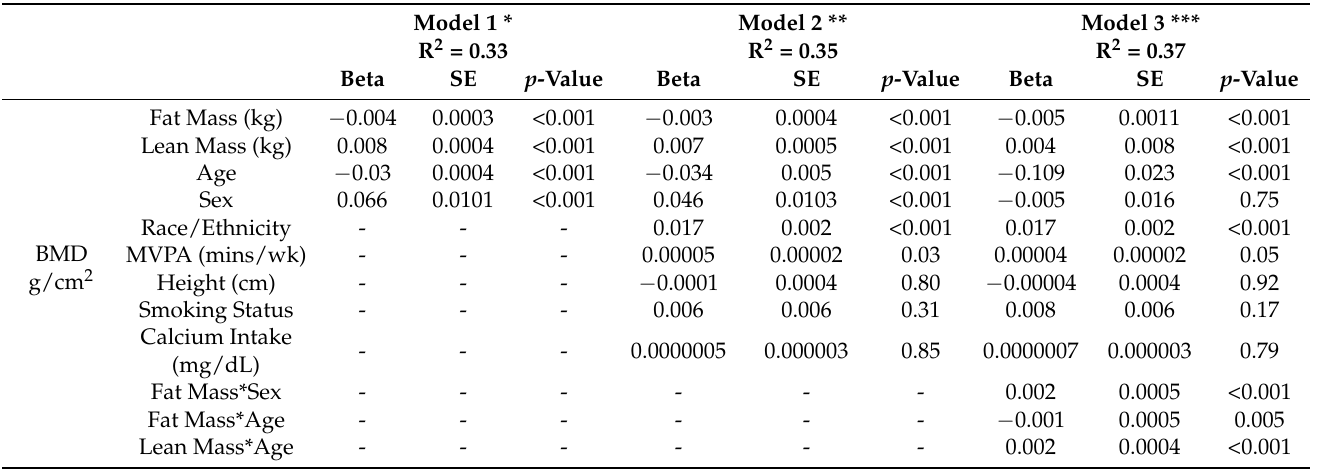
Table 2. Regression analysis models examining the associations between bone mineral density (g/cm 2 ) and other variables. Model 1 * Model 2 ** Model 3 ***